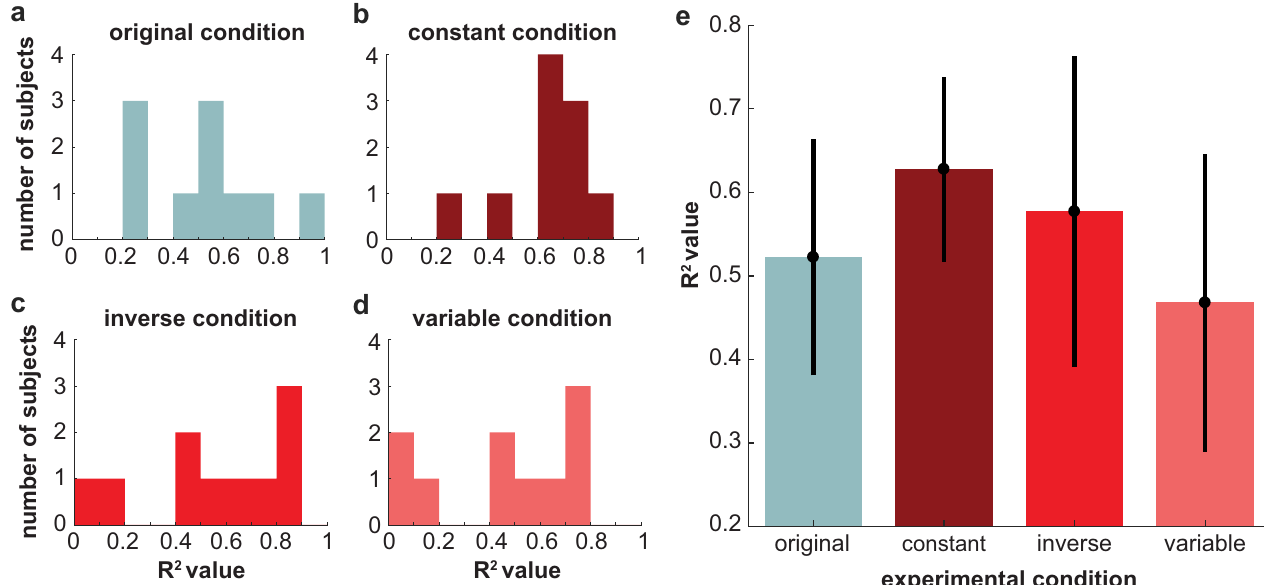
Fig 7. Histograms of the coefficient of determination, R 2 in (a) the original condition , (b) the constant condition , (c) the inverse condition , and (d) the variable condition of Experiment 1. (e) Average coefficient of determination, R 2 , in each experimental condition. Error bars show ± 2 standard errors of the mean. There was no significant effect of experimental condition on the R 2 values.